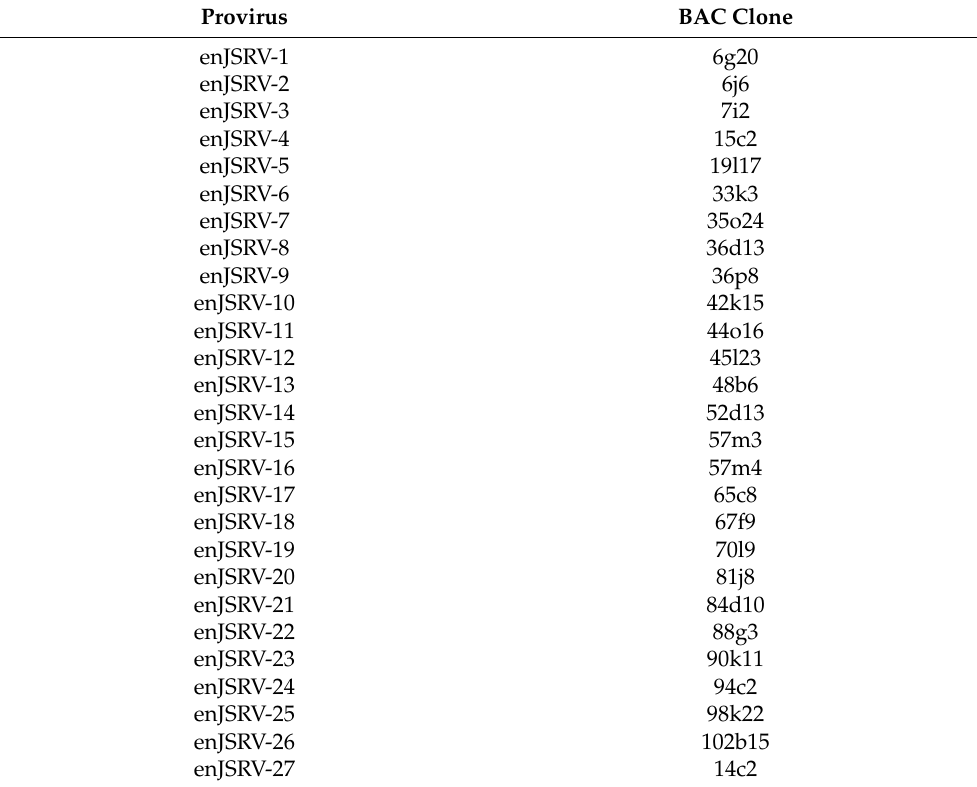
Table 1. List of sheep BAC clones containing the 27 enJSRVs used in the present study.